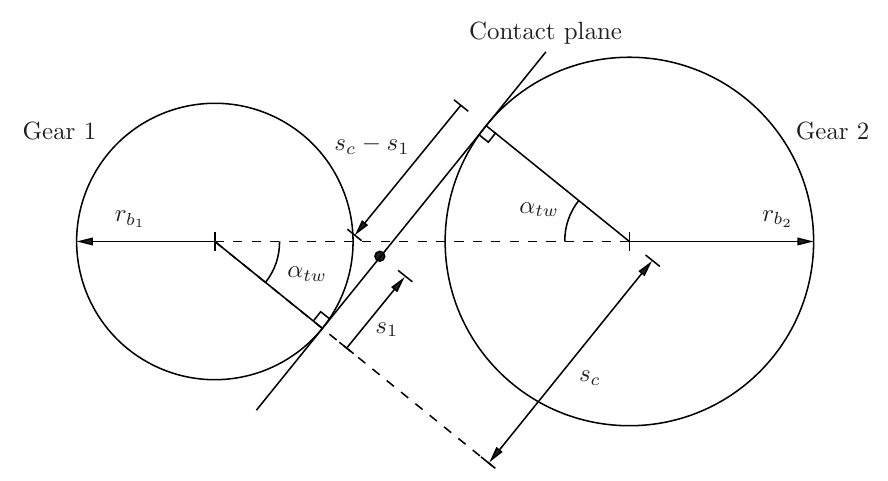
Figure 4: Basic gear geometry, the dot indicates a contact point on the contact line.